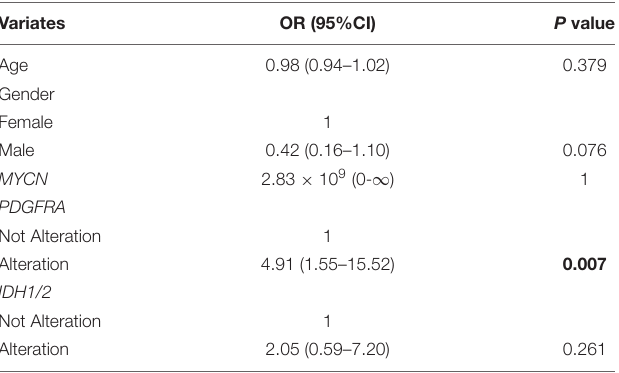
TABLE 2 | Correlative factors of ccGBM analyzed by multivariate logistic regression. Variates